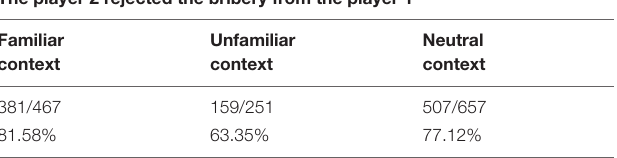
Table 7 | Proportions of offers being rejected by player 2. The player 2 rejected the bribery from the player 1